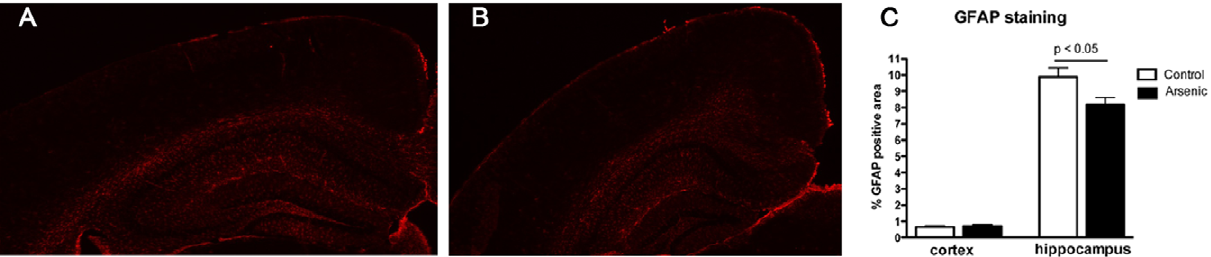
Figure 4. GFAP staining is decreased in mice exposed to arsenic. A & B . Staining on brain sections (A, control; B, arsenic exposed) using anti- GFAP antibody was used as a marker for astrocytes. Representative pictures illustrate the difference in GFAP staining in hippocampal area of control and arsenic treated mice. C . For graphical presentation, the intensity of staining in cortex and hippocampus was quantitated as explained in the methods. Analysis is by t-test. N=7–8 mice per